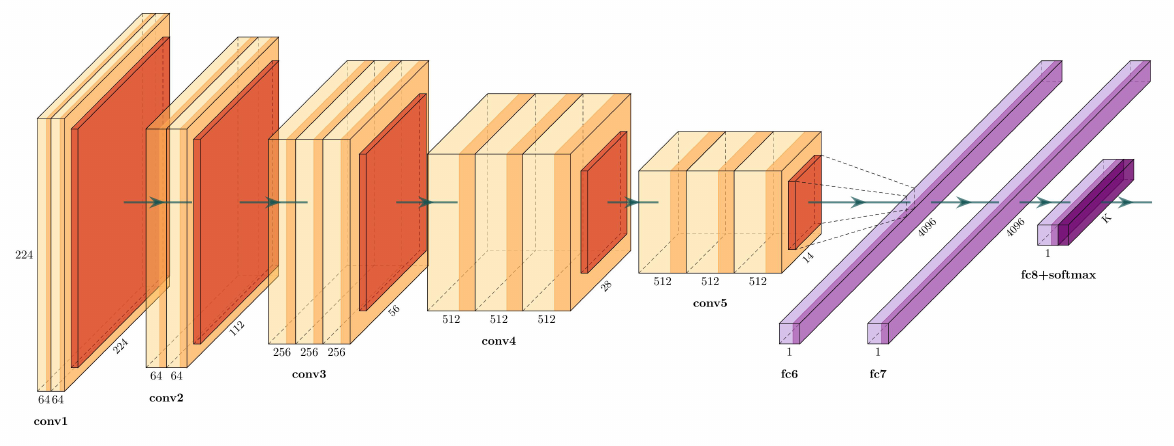
Figure 3. Architecture of the